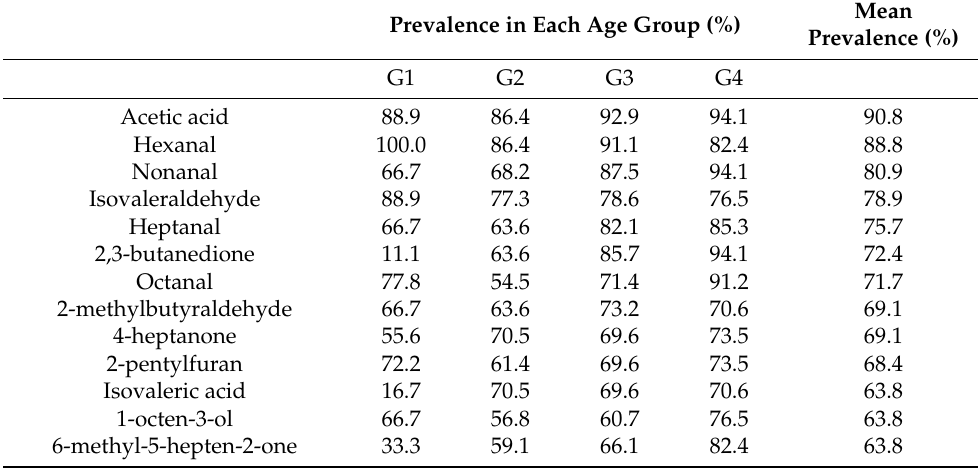
Table A1. The prevalence of the 36 most abundant volatile in the four age